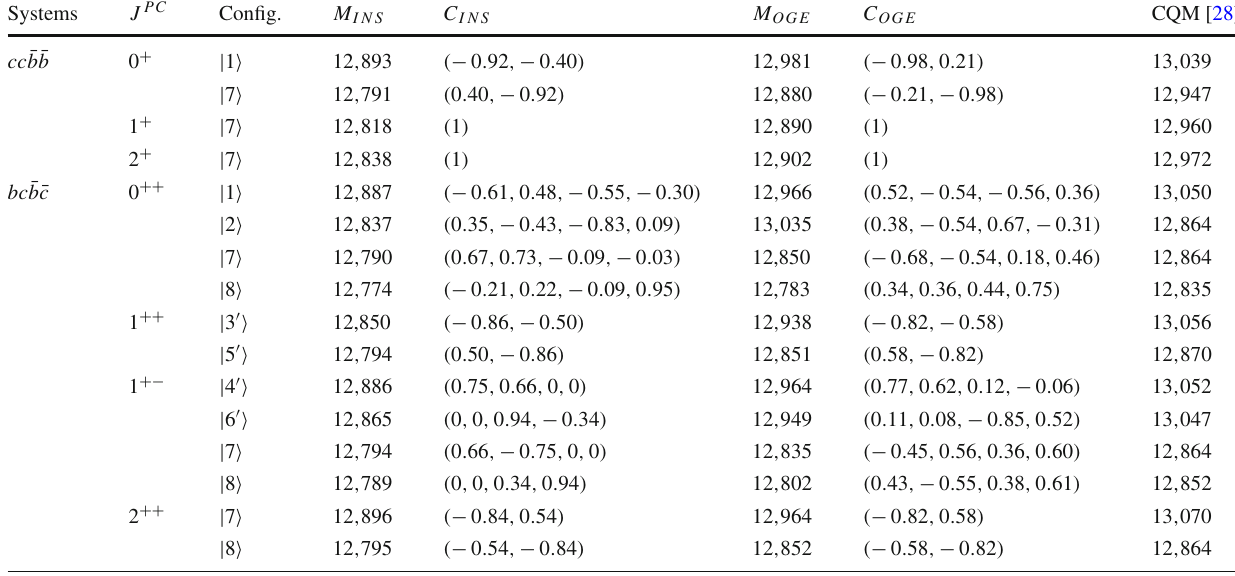
Table 5 The numerical results of spectrum for the S -wave cc ¯ b ¯ b and bc ¯ b ¯ c states compared to the predictions in Ref. [28], conventions are the same as in Table 4 Systems